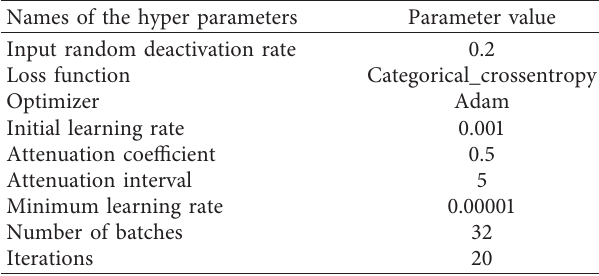
Figure 3: Structure diagram of the model of the improved convolution neural network and LightGBM. Table 1: Hyperparameter setting of the improved convolution neural network.